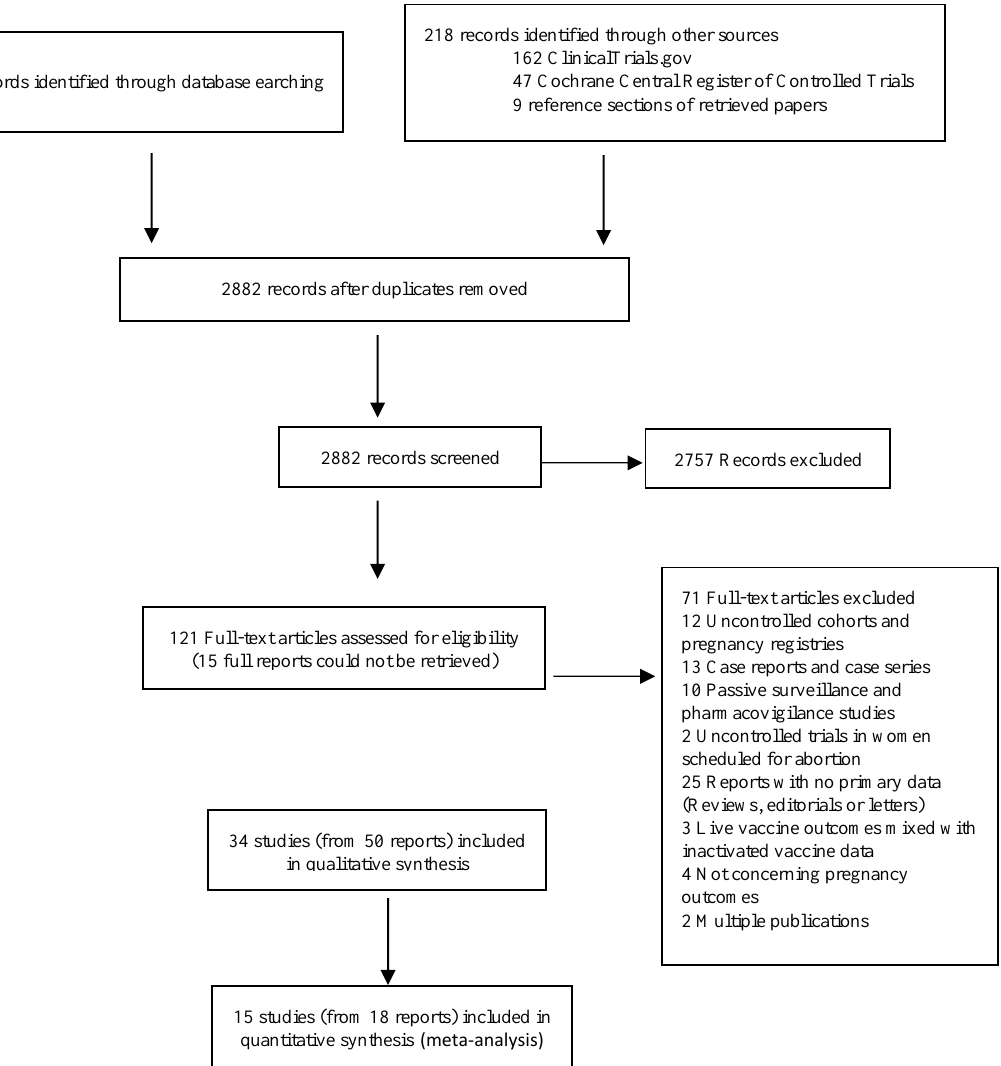
Figure 1. Flowchart showing the study selection process for the qualitative and quantitative synthesis.